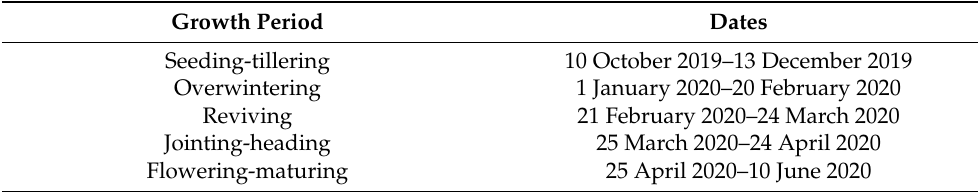
Table 1. Dates corresponding to the five different growth periods in the study area.